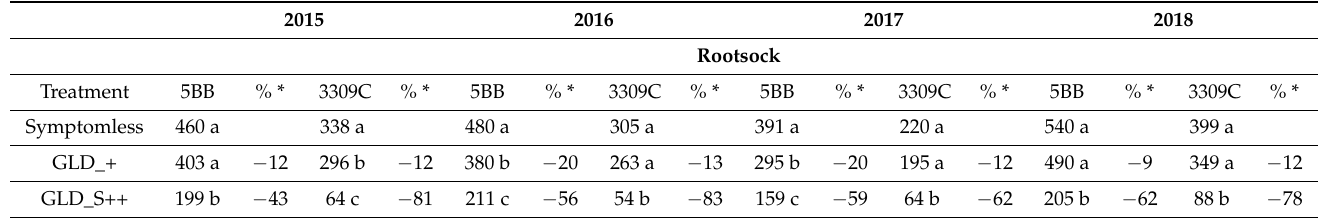
Table 1. Effect of rootstock and virus status on vine vigor (weight of pruning wood (g/vine)) on V. vinifera cv. Pinot noir over four consecutive years. GLD_S+: Grapevine leafroll disease causing mild symptoms; GLD_S++: grapevine leafroll disease causing severe symptoms. Means were denoted by different letters (a, b, and c) when they differ significantly at p < 0.05 using Ducan’s new multiple range test.